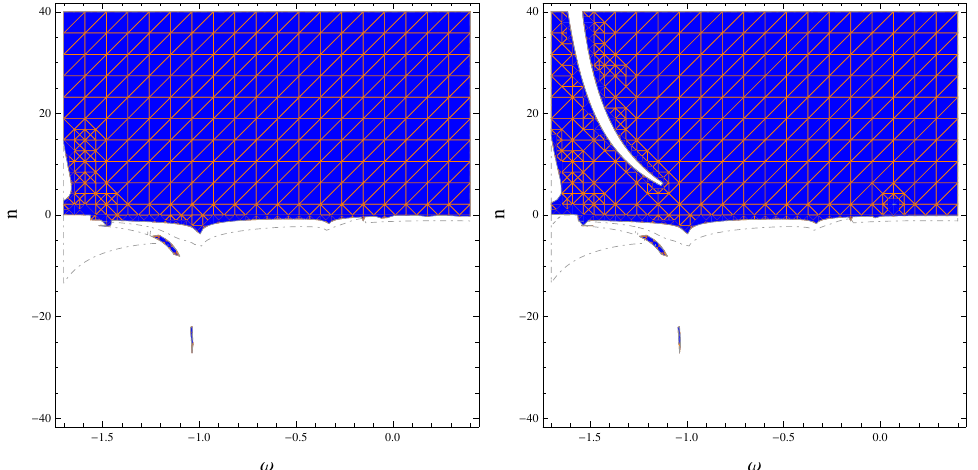
Figure 5. Stable regions of the ESU for K = 1, λ 2 = 2 (blue) and λ 2 = 15 (orange), corresponding to η = 7 ( left ); η = − 7 ( right